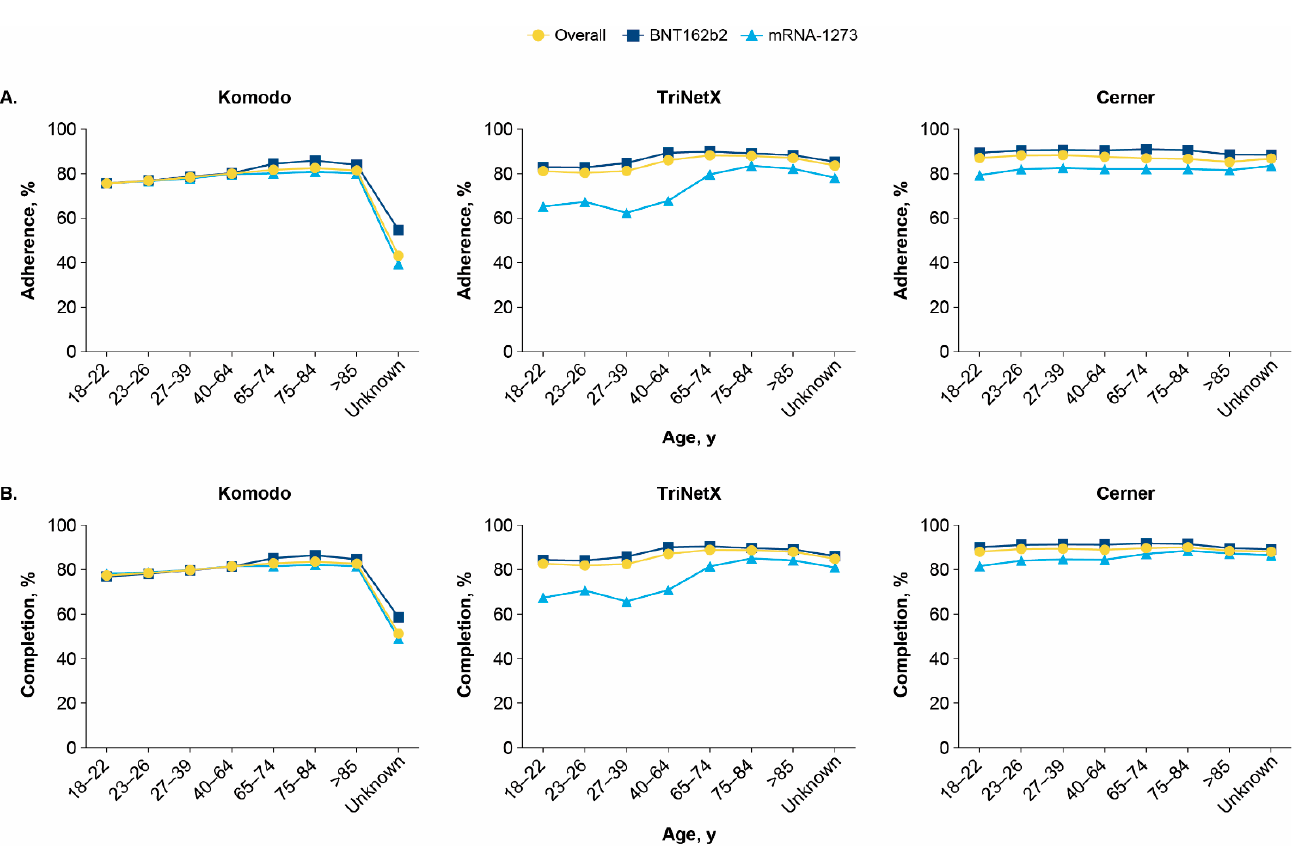
Figure 2. ( A ) Adherence and ( B ) completion stratified by age (years) in the Komodo, TriNetX, and Cerner databases.